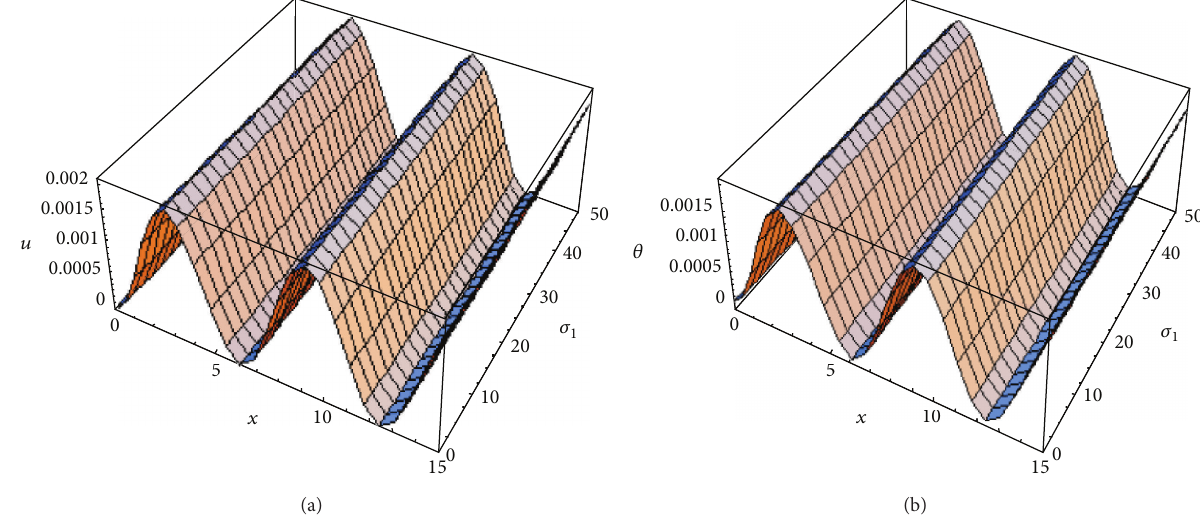
Figure 5: Variations of the displacement 𝑢 and the temperature 𝜃 for various values of the 𝑥 -axis and magnetic field 𝜎 1 when 𝑡 = 0.1 , 𝜏 2 = 0 , = 0.1 , 𝛿 = 1 , 𝜎 = 0.1 , Ω = 0.1 , and 𝜔 = 0.02 . 𝜏 1 2